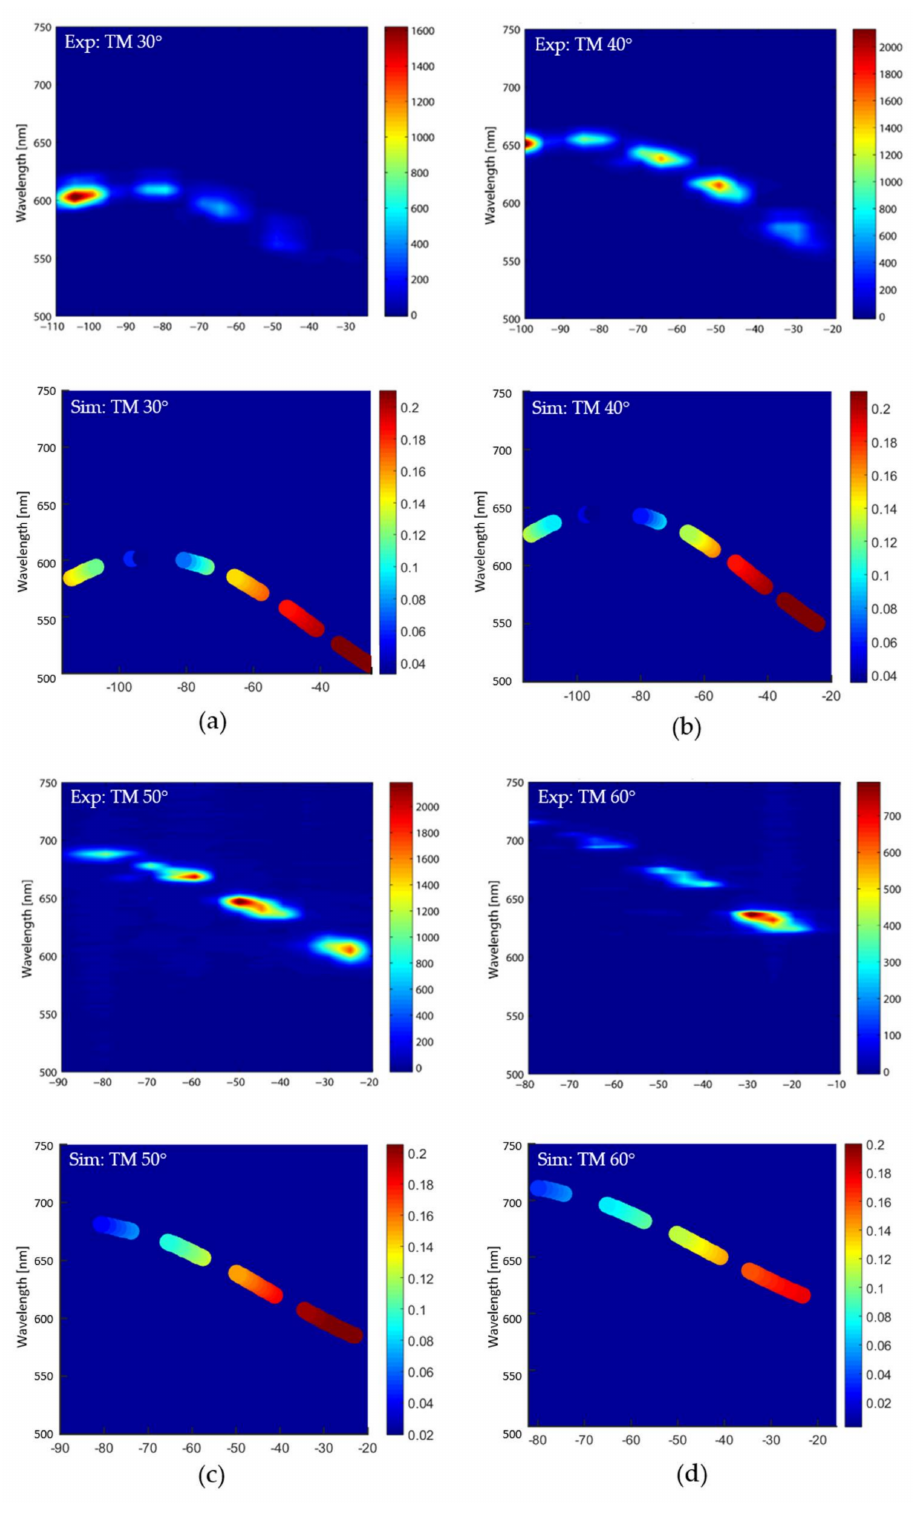
Figure 8. Experimental (top panels) and simulated (bottom panels) spectral-angular map of TM polarized incident light for incident angles 30 ◦ ( a ), 40 ◦ ( b ), 50 ◦ ( c ), and 60 ◦ ( d ). The intensity scales are in the same units for all maps of the TM polarization. Simulated data are matched to experimental data by considering maximum intensity in a